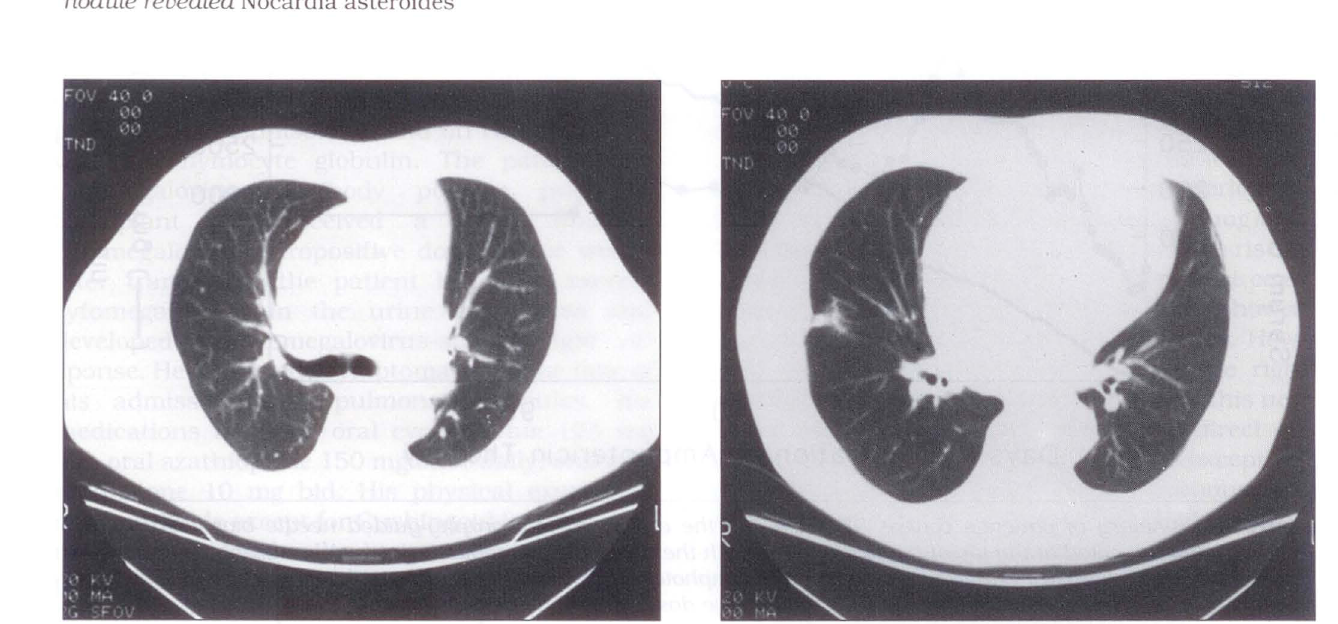
Figure 4) Computed tomography scan of the chest after 13 weeks of treatment with amphotericin B and nine weeks of treatment with sulfiSoxazole shows resolution of all right upper lobe nodules (left). A parenchymal scar is seen in the middle lobe at the site of the 'new' nodule